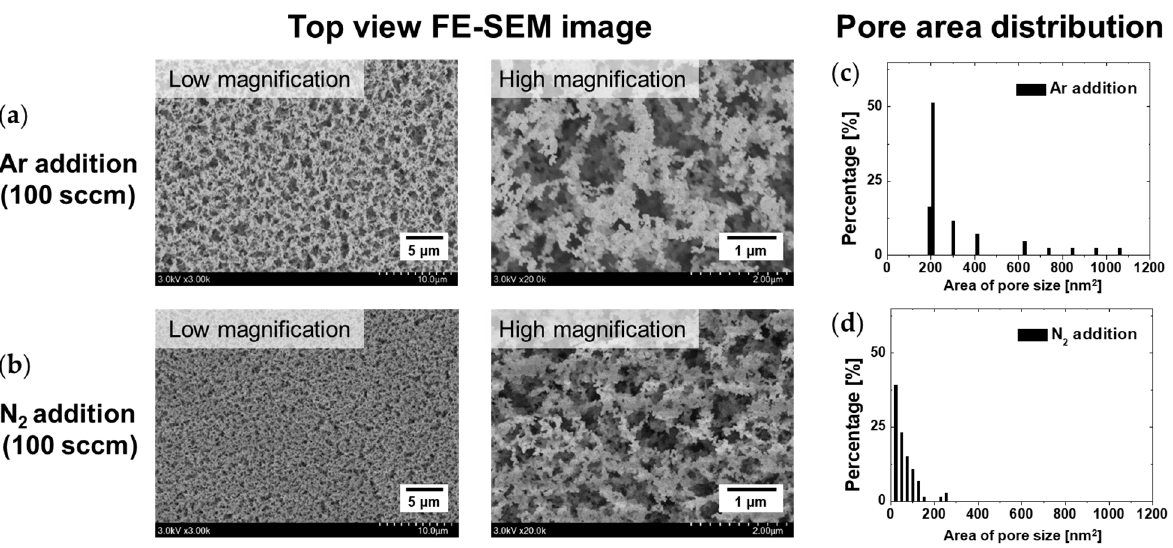
Figure 5. FE-SEM measurements of PANI films synthesized with the addition of ( a ) Ar and ( b ) N 2 (top view). Pore area distribution based on the high-magnification FE-SEM images of PANI films synthesized with the addition of ( c ) Ar and ( d ) N 2 .